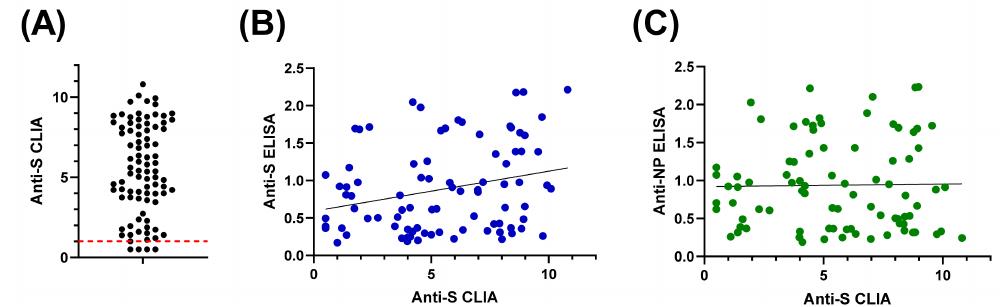
Figure 5. Compairson and correaltion of COVID-19 NP and S IgG ELISAs with FDA-approved CLIA. ( A ) The result obtained from CLIA for all samples that were tested positive by MN assay, S- and NP-based ELISAs. ( B ) Signficant correlation between CLIA and S-based ELISA; r 2 = 0.2595 and p value = 0.015. ( C ) Lack of correlation between CLIA and NP-based ELISA; r 2 = 0.0167 and p value =